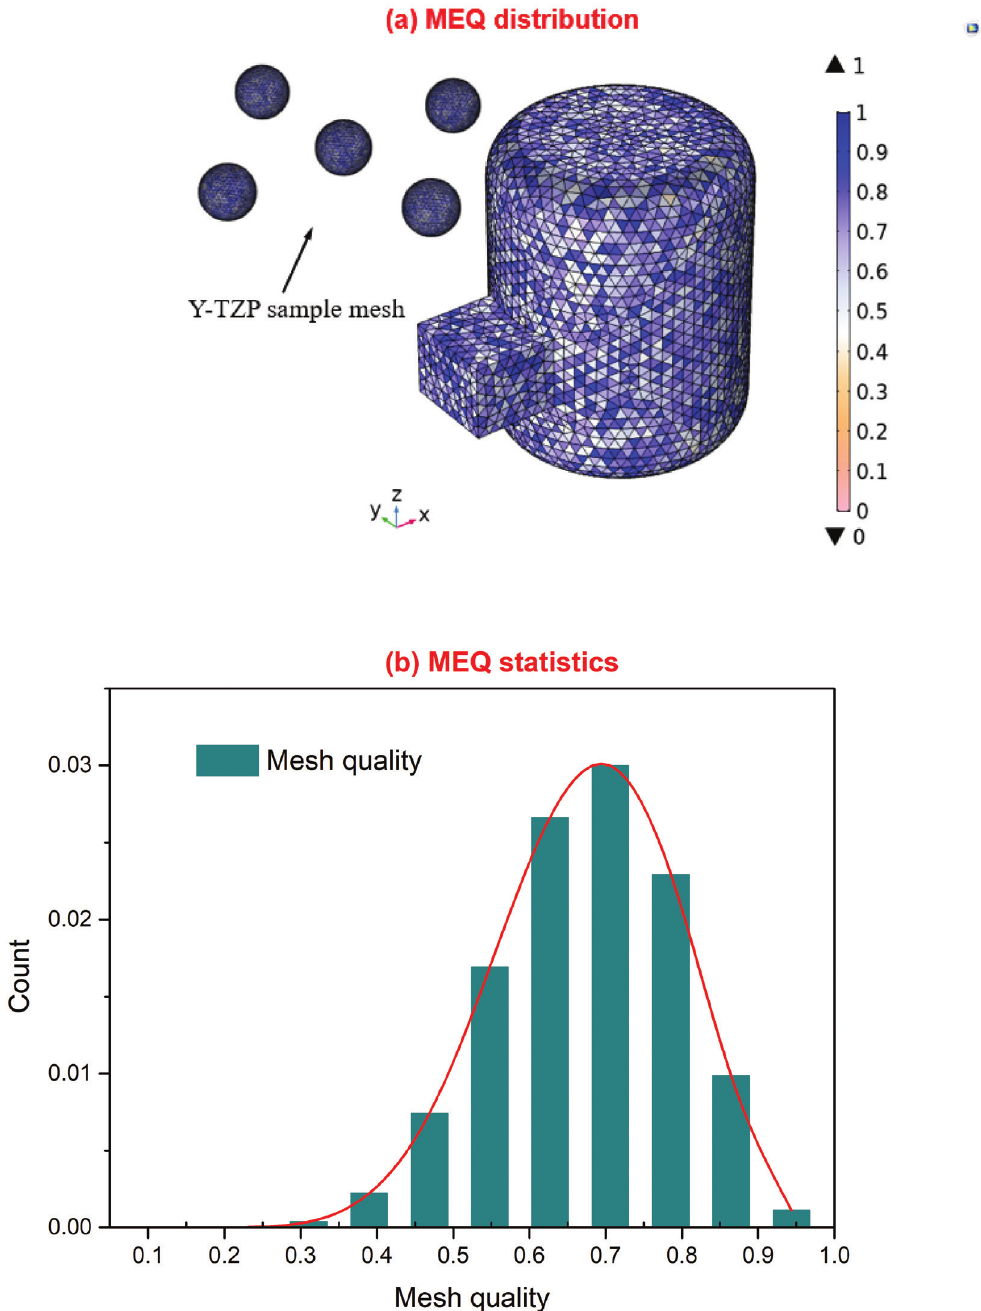
Figure 2: Construction of resonant cavity grid: (a) the visualization of MEQ distribution in model, (b) the MEQ statistics in the